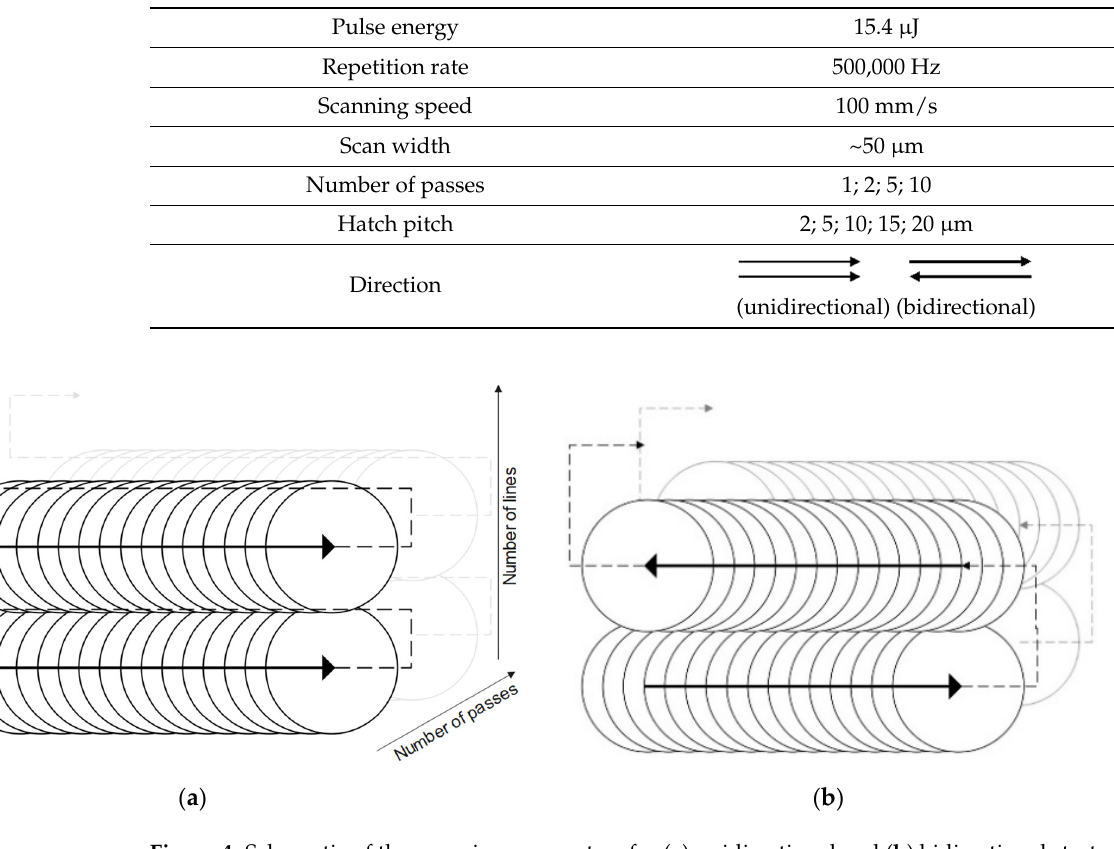
Figure 4. Schematic of the scanning parameters for ( a ) unidirectional and ( b ) bidirectional strategy. The continuous bold arrows represent the laser path in the pulsed mode. The dotted arrows represent the laser path without ablation.